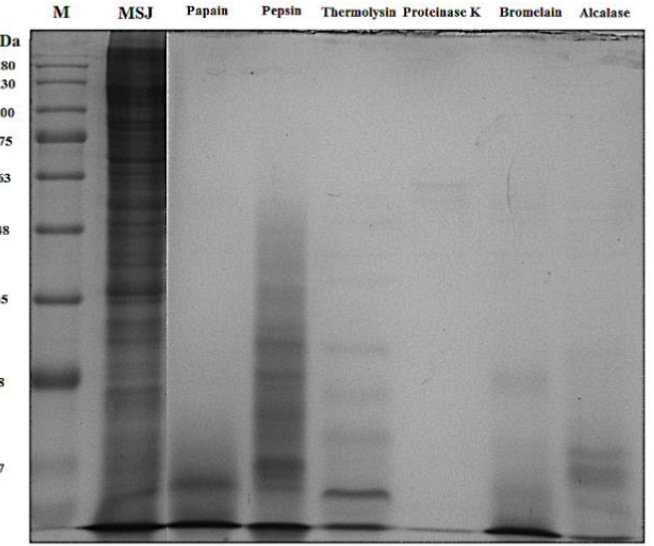
Figure 7. SDS-PAGE protein patterns of Mackerel Steaming Juice (MSJ) and MSJ hydrolysates from six proteases (papain, pepsin, thermolysin, proteinase K, bromelain, and alcalase). Antioxidant activities, 2,2-diphenyl-1-picrylhydrazyl (DPPH) radical scavenging ac- tivity, metal chelating activity and reducing power, of MSJ and MSJ hydrolysates were